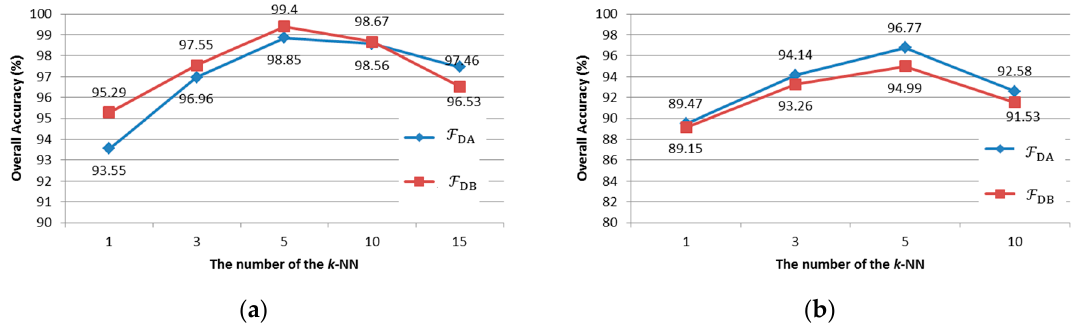
Figure 5. Overall accuracy with different number of NNs. ( a ) Pavia University dataset; ( b ) Indian Pines dataset.